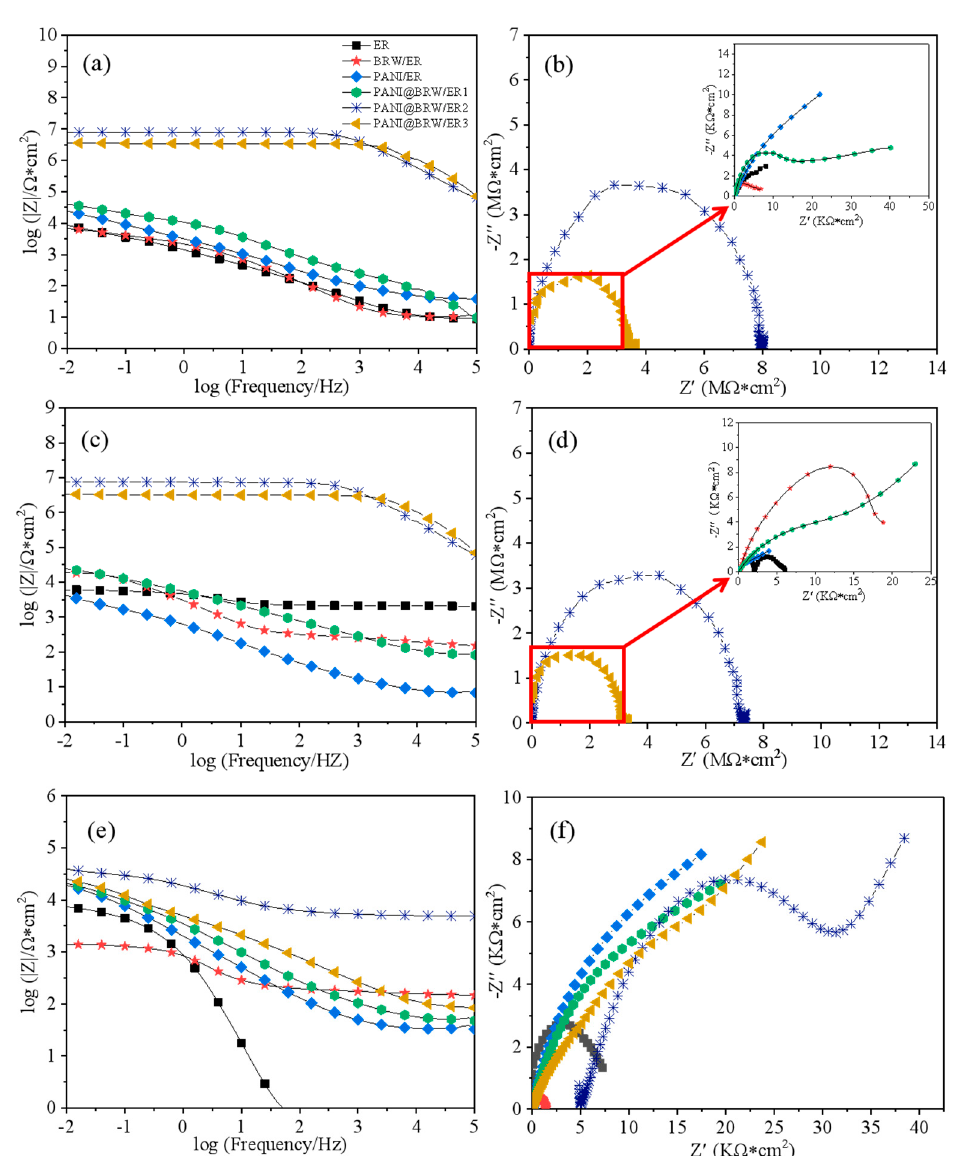
Figure 11. Bode plots and Nyquist plots of the ER, BRW/ER, PANI/ER, PANI@BRW/ER1, PANI@BRW/ER2, and PANI@BRW/ER3 coatings after 0 h ( a , b ), 72 h ( c , d ), and 168 h ( e , f ) immersion.